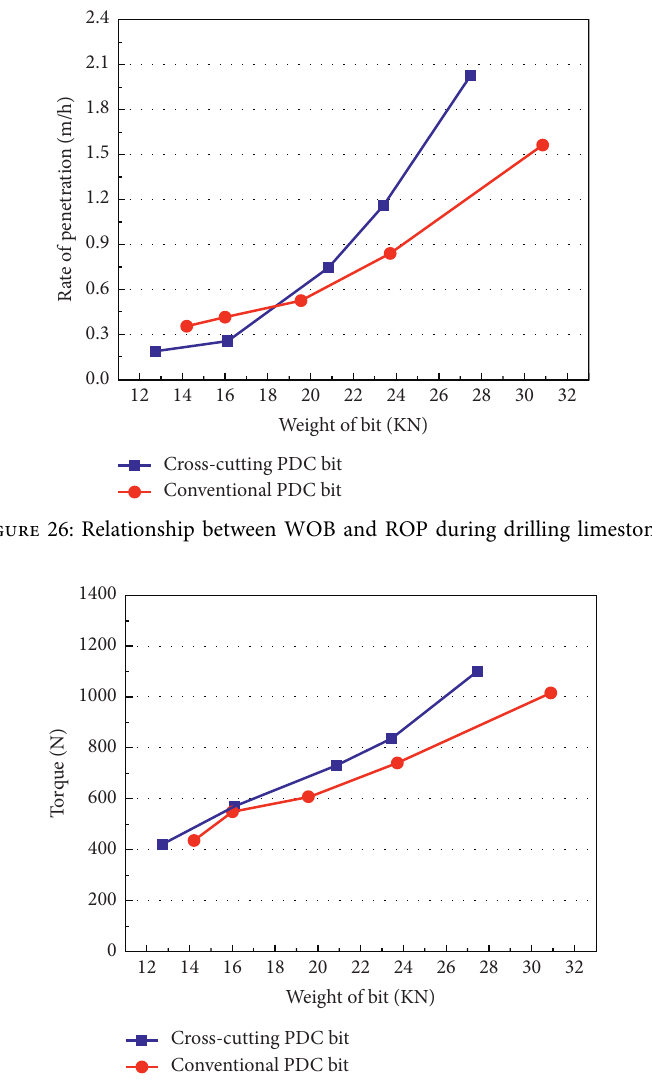
Figure 27: Relationship between WOB and torque during drilling limestone.